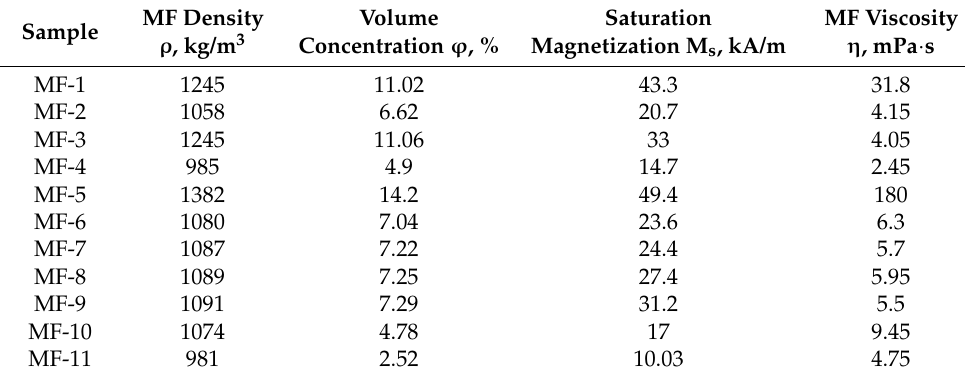
Table 1. Physical parameters of MF